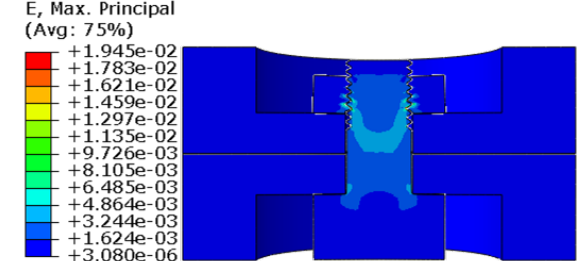
( b ) Figure 11. Von Mises equivalent stress and maximum principal strain contours of the bolt and nut at 550 ° C: ( a ) Von Mises equivalent stress; ( b ) maximum principal strain. ( a ) ( b ) Figure 12. Von Mises equivalent stress and maximum principal strain contours of the bolt and nut at 650 °C: ( a ) Von Mises equivalent stress; ( b ) maximum principal strain.